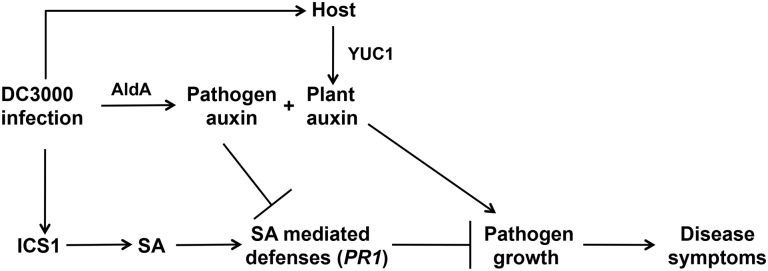
IAA promotes pathogenesis via multiple mechanisms.